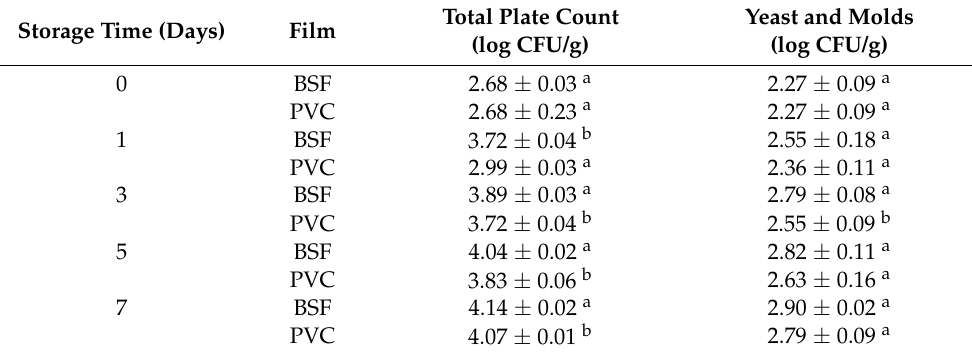
Table 5. The microbiological quality of minced pork wrapped with banana starch film incorporated with banana peel extract and PVC films (log